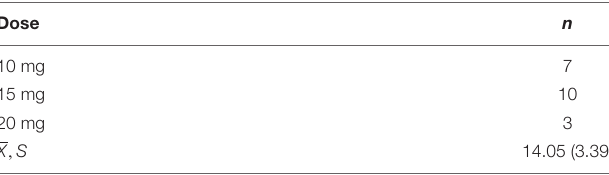
TABLE 1 | MPH dosing frequencies in the study.